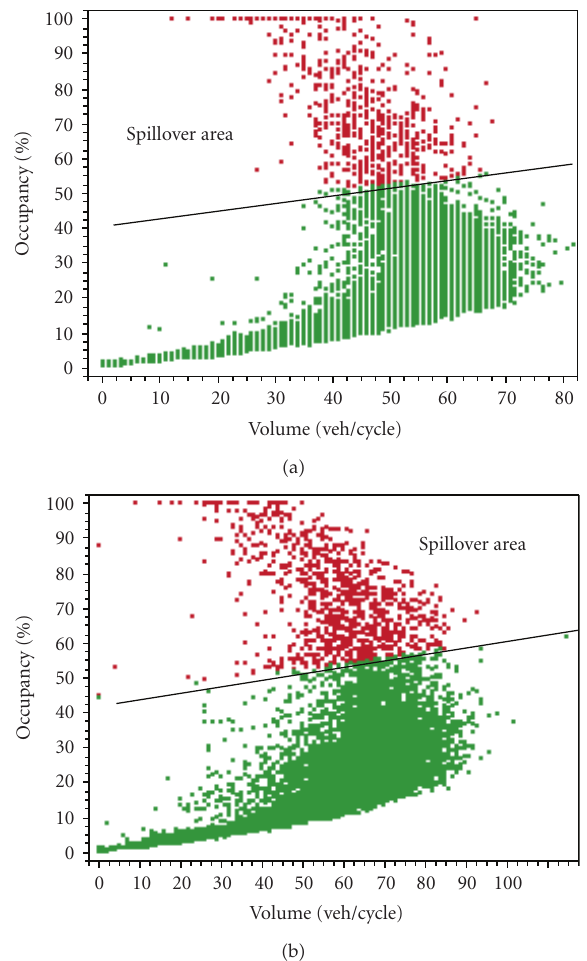
Figure 3: Volume-occupancy relationship for two consecutive signalized arterial links (cid:3) the black thick line represents the boundary of the congestion area after which queue spillovers are observed in the arterial link (cid:4)